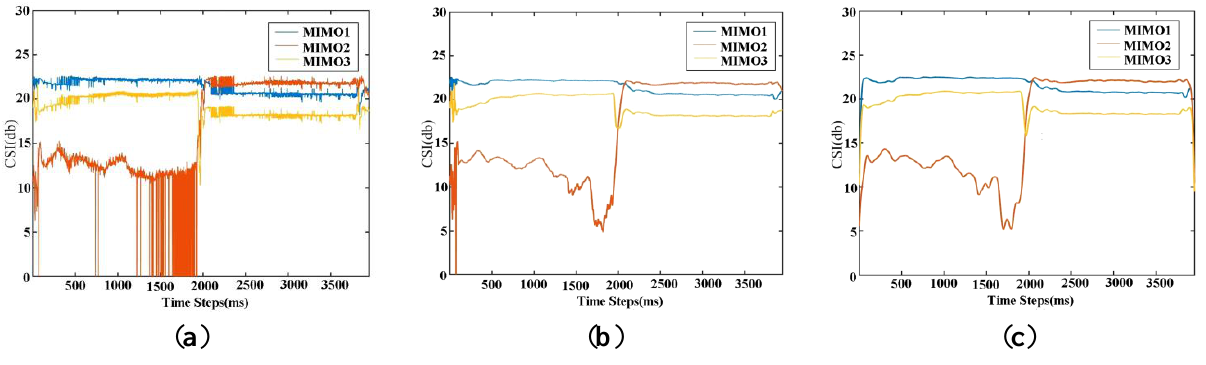
Figure 1. The MIMO subplots of sitting down onto a chair. ( a ) The original CSIs; ( b ) The filtered CSIs by average weight; ( c ) The filtered CSIs by Single-sideband Gaussian (SG) weight. It is obvious SG weight outperforms the average weight in time region 0–5 ms and 1500–2000